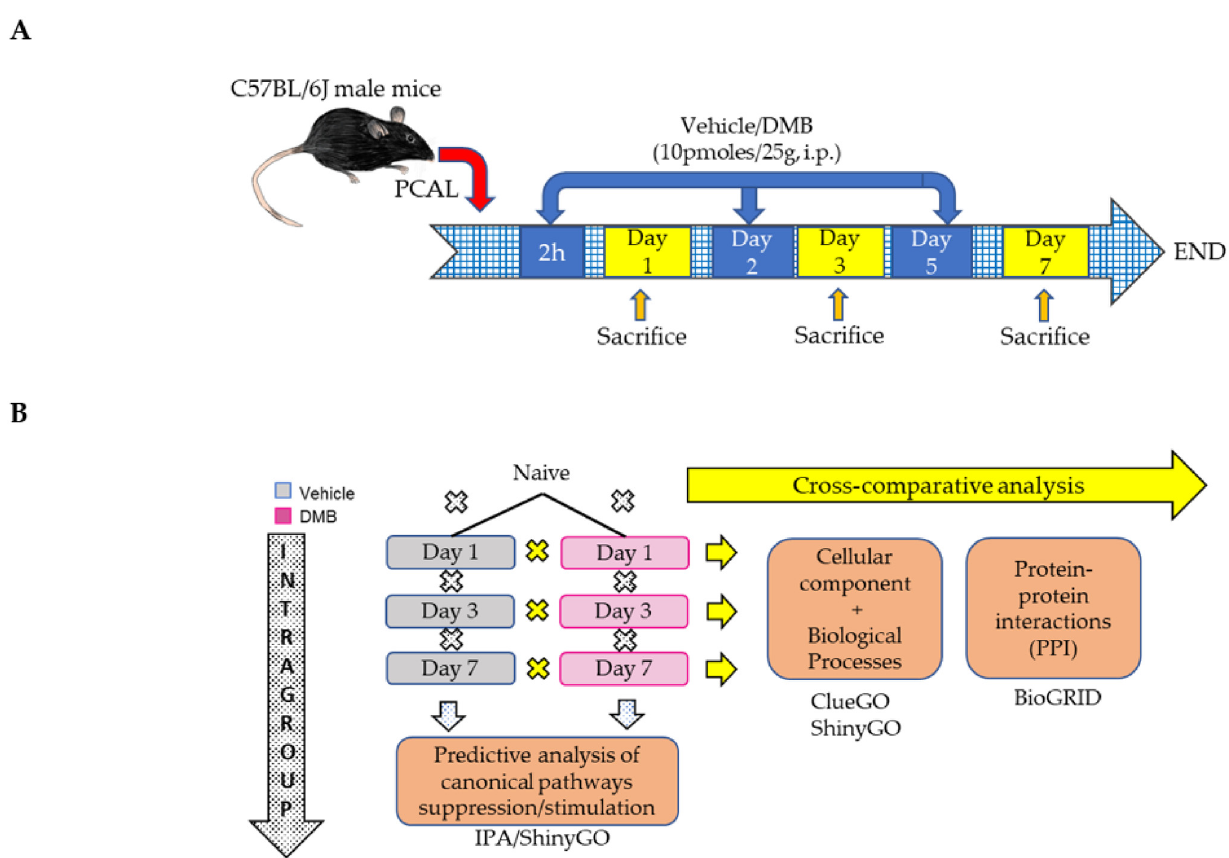
Figure 1. Schematics. C57BL/6J male mice (except naïve) were treated with either 10 pmoles of DMB or vehicle (DMSO) 2 h after permanent coronary artery ligation (PCAL) surgery and every other day or two ( n = 3/group). Mice were sacrificed after 1, 3 or 7 days of surgery. ( A ) An in vivo model of PCAL surgery and treatment; ( B ) in silico analysis schematic: samples followed the intragroup analysis, when each time point was compared to its preceding time point in each group, separately; or samples followed a cross-comparative analysis, when protein expression from DMB-treated mice was compared to protein expression in the vehicle-treated group at each time point. i.p., intraperitoneal; IPA, ingenuity pathway